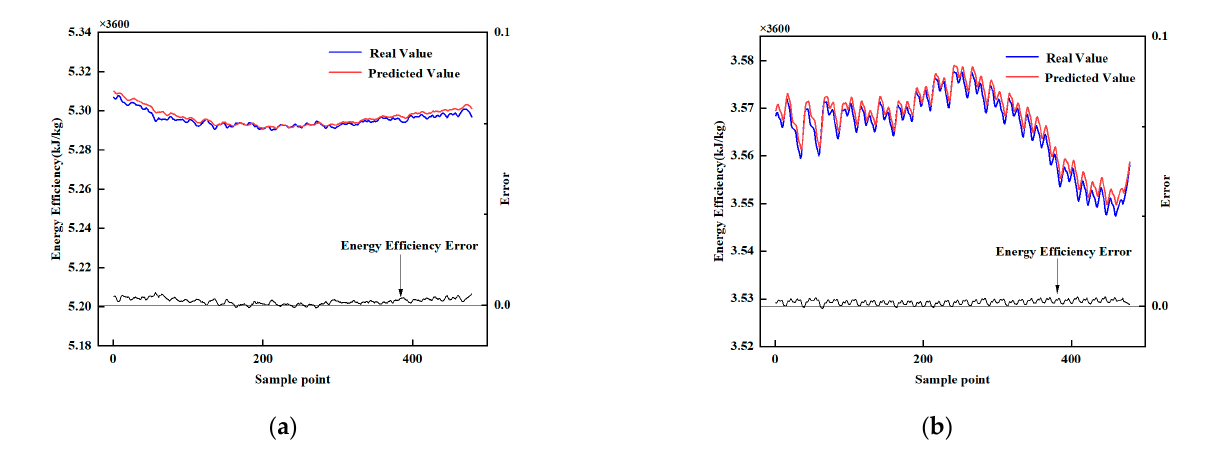
Figure 15. Product energy-efficiency prediction of working condition 4. ( a ) Prediction of energy efficiency of atmospheric two-line products. ( b ) Prediction of energy efficiency of vacuum two-line products.